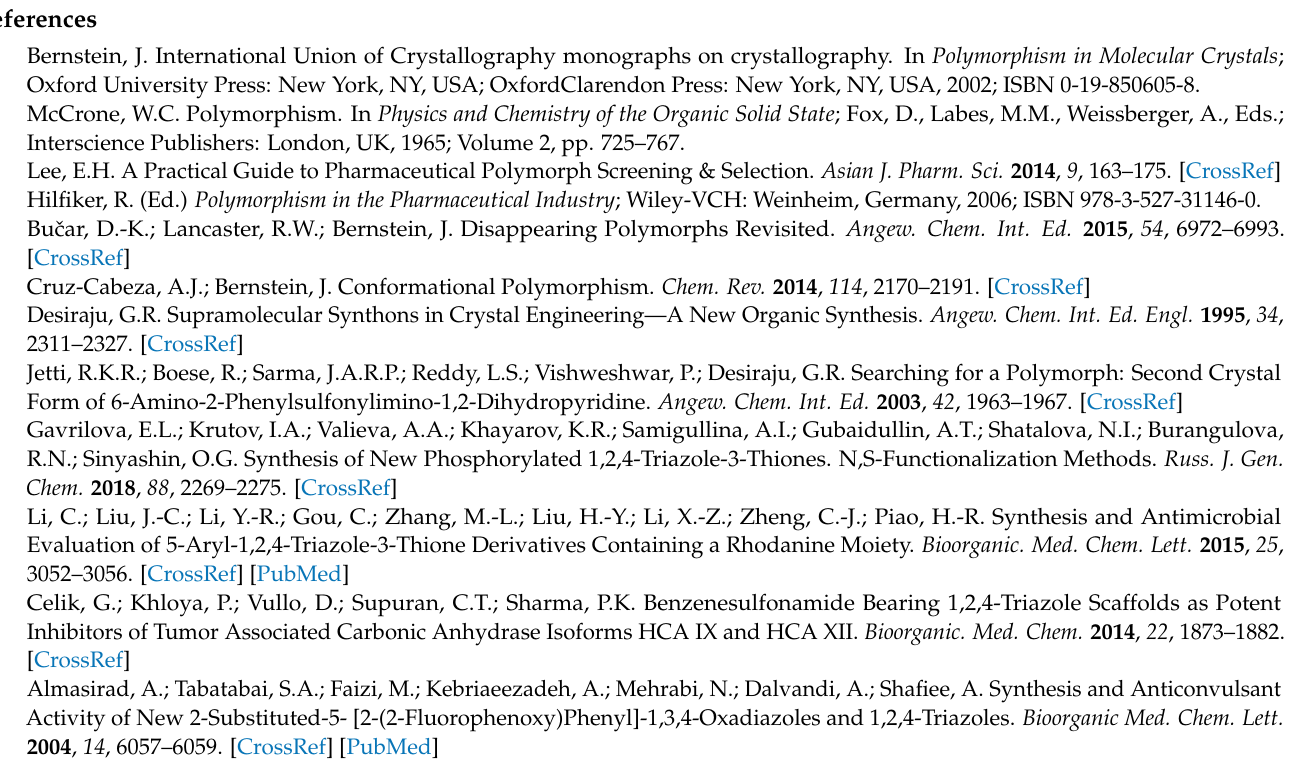
molecular projections along rotable bonds, Figure S6: molecular graphs of the polymorphs, Figure S7: overlay of the lowest-energy conformer and optimized conformer from 1b , Figure S8: connectivity graph of the H-bonded dimer in 1a (DFT), Figure S9: connectivity graph of the H-bonded chain in 1b (DFT), Figure S10. Hirshfeld fingerprint plots for polymorphs, Table S1: calculated energy values (DFT), Table S2: Intermolecular bonding interactions in 1a (DFT)), Table S3: Intermolecular bonding interactions in 1b